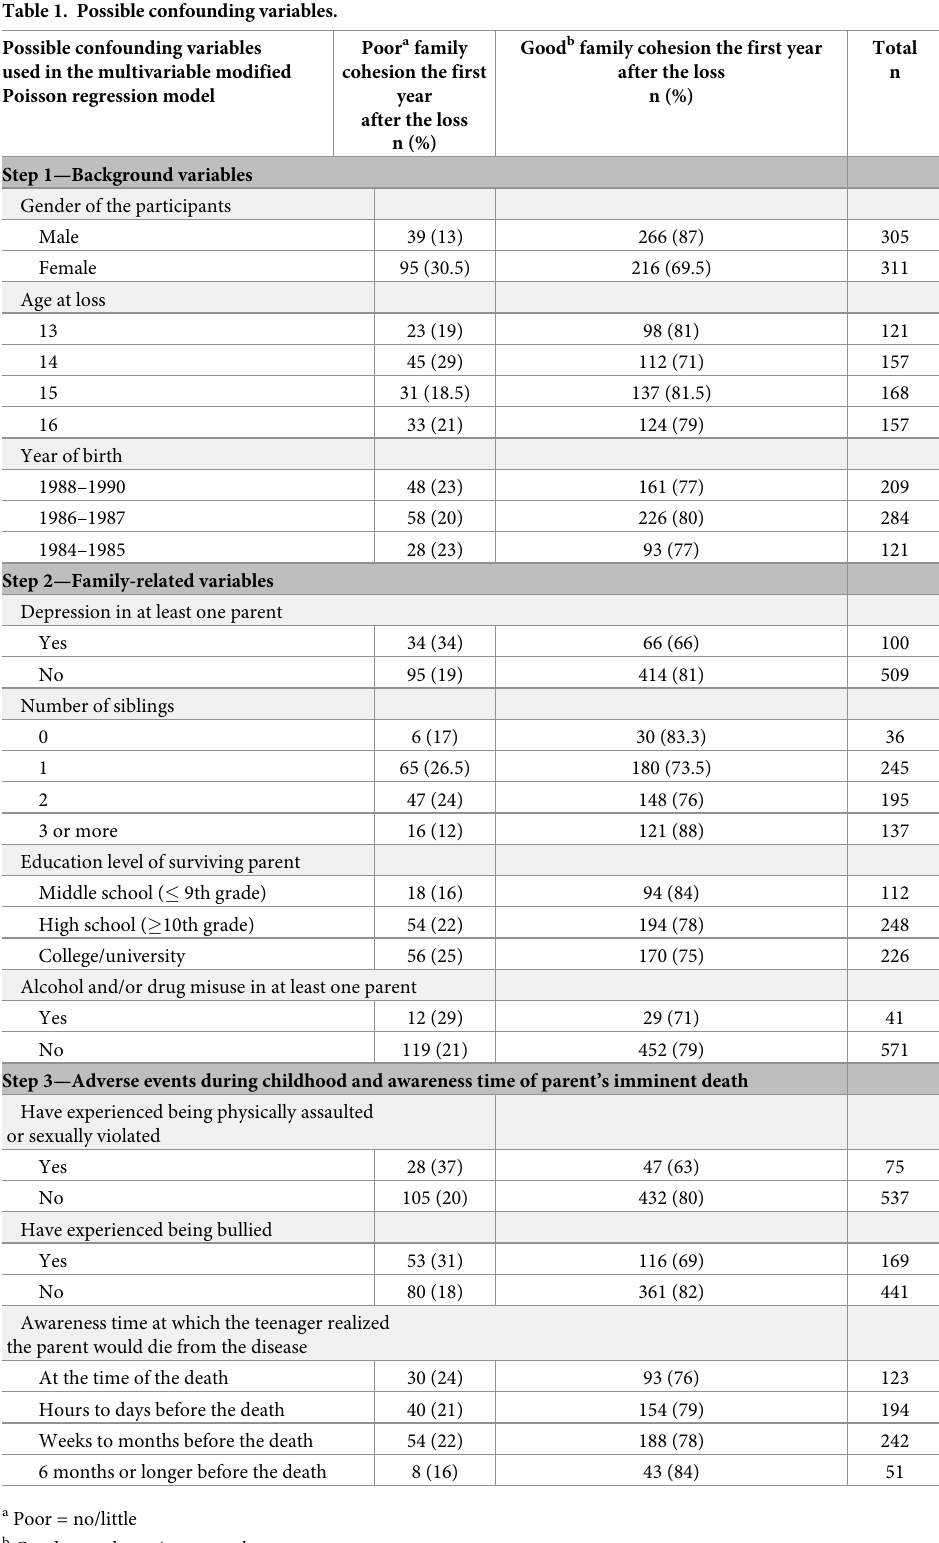
Good b family cohesion the first year Poor a family cohesion the first after the loss year n (%) after the loss n (%)